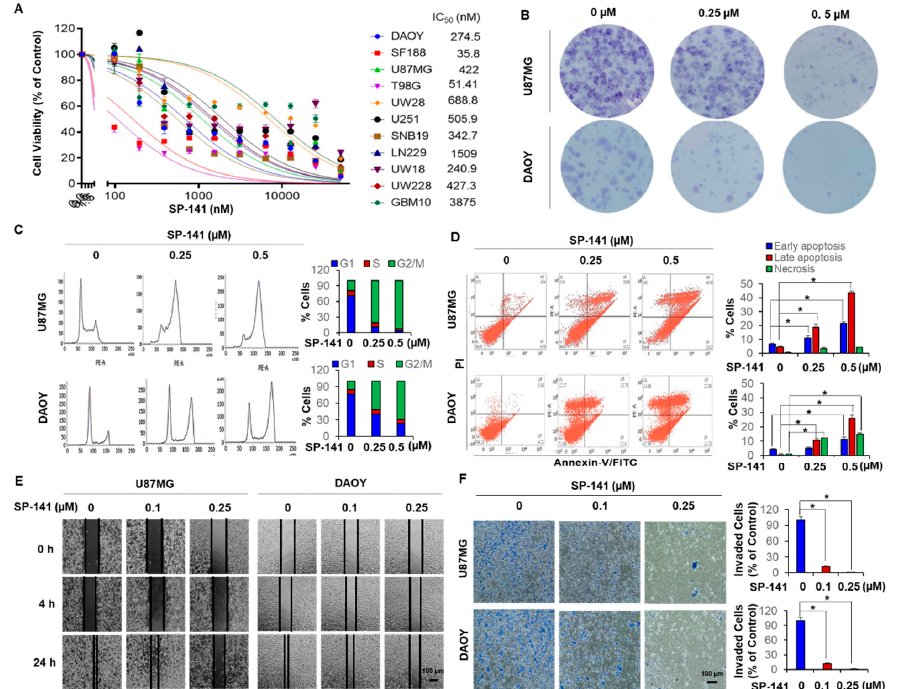
Figure 1. SP-141 shows therapeutic potential in p53 wt and p53 mutant brain tumor cell lines. ( A ) Cytotoxicity of SP-141 against brain tumor cell lines. Cell growth inhibition was analyzed by the resazurin reduction assay (data represent the results of three independent experiments performed in triplicate). Cells were treated with different dilutions of the compound (0–25 µM) for 72 h. Cytotoxicity (IC 50 ) values in nM are stated for each cell line. ( B ) Colony formation of two representative cell lines. Cultured DAOY and U87MG cells were treated with SP-141 at different concentrations for 24 h. Twenty-one days after drug removal, cells were fixed and stained with crystal violet and images were prepared. ( C ) Analysis of cell cycle progression after treatment with different concentrations of SP-141 for 24 h. ( D ) Apoptosis analysis by flow cytometry using the Annexin V-FITC/PI stain assay. U87MG and DAOY cells were incubated with various concentrations of SP-141 for 24 h then were stained with membrane phosphatidylserine-binding Annexin V-FITC and propidium iodide (PI) (panels Lower Left: FITC Annexin V- and PI- negative; Lower Right: Annexin V-FITC positive; Upper Right: FITC Annexin V- and PI-positive; Upper Left: PI-positive) (* p < 0.01). ( E ) Cell migration. U87MG and DAOY cells were grown to confluence in six-well plates and a scratch was made at the start of the experiment. The cells were then exposed to SP-141 at the concentrations shown. The wells were imaged at different time points. Scale bars: 100 µm. ( F ) U87MG and DAOY cells were subjected to a Transwell invasion assay 12 h after treatment with SP-141 (0, 0.1, and 0.25 µM) as specified. The crystal violet dye staining images of lower chambers with migrated cells are shown (* p < 0.01). Scale bars: 100 µm.